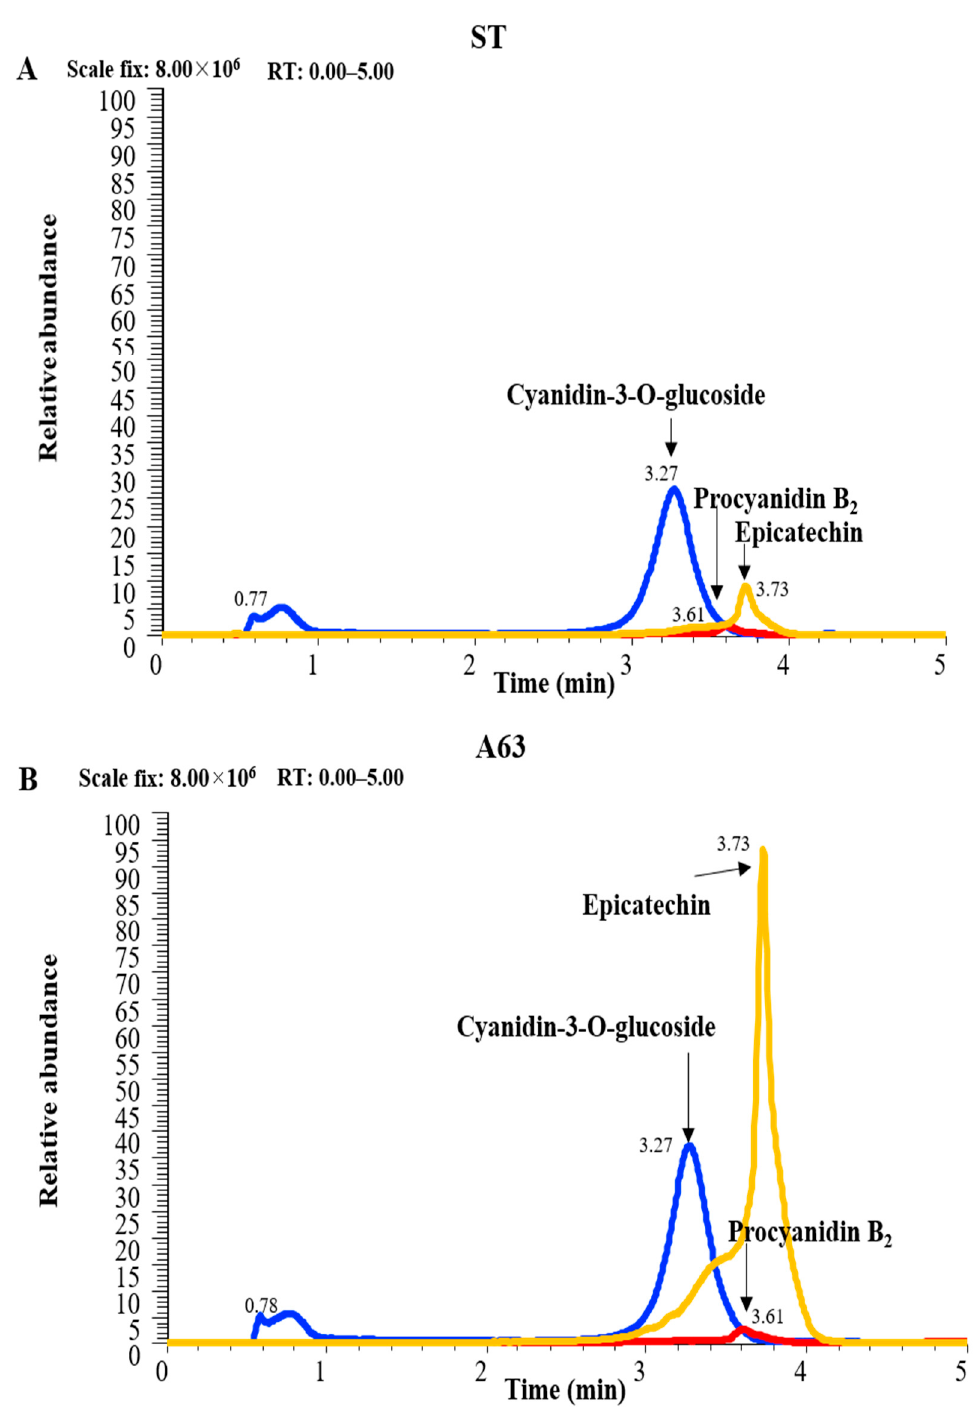
Figure 1. HPLC analysis of ST and A63 extract and its major compounds. Typically extracted ion chromatogram of three major anti-oxidants, Cyanidin-3- O -Glucoside (C3G), procyanidin B2 (PB2), and epicatechin (EP), in Korean black soybean cultivar ST ( A ) and A63 ( B ). 2.2. A63 Extract Attenuates Oxazolone-Induced AD-like Skin Inflammation in Mice Oxazolone (OXA) sensitization was performed to induce AD-like skin inflammation and evaluate the effect of A63 extract in a murine model of atopic dermatitis. A63 extract treatment significantly decreased epidermal thickness in the ear tissue to a level compa- rable with that of the dexamethasone (Dex) group (Figure 2A). Allergic and inflammatory